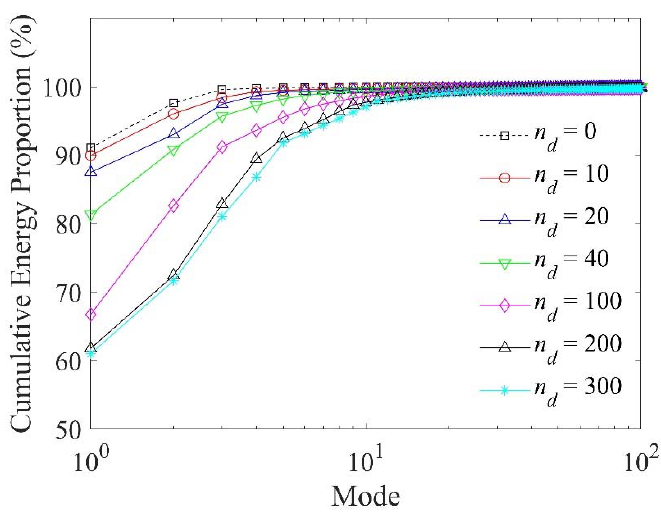
Figure 6. POD mode energy spectrum of the time-delay embedded data with different n d . The raw and reconstructed pressure data of sensor #1 were used to compare the reconstruction performance of the standard DMD and DMD with delay embedding. Sensor #1 is located at the leading edge, where the most obvious pressure fluctuations